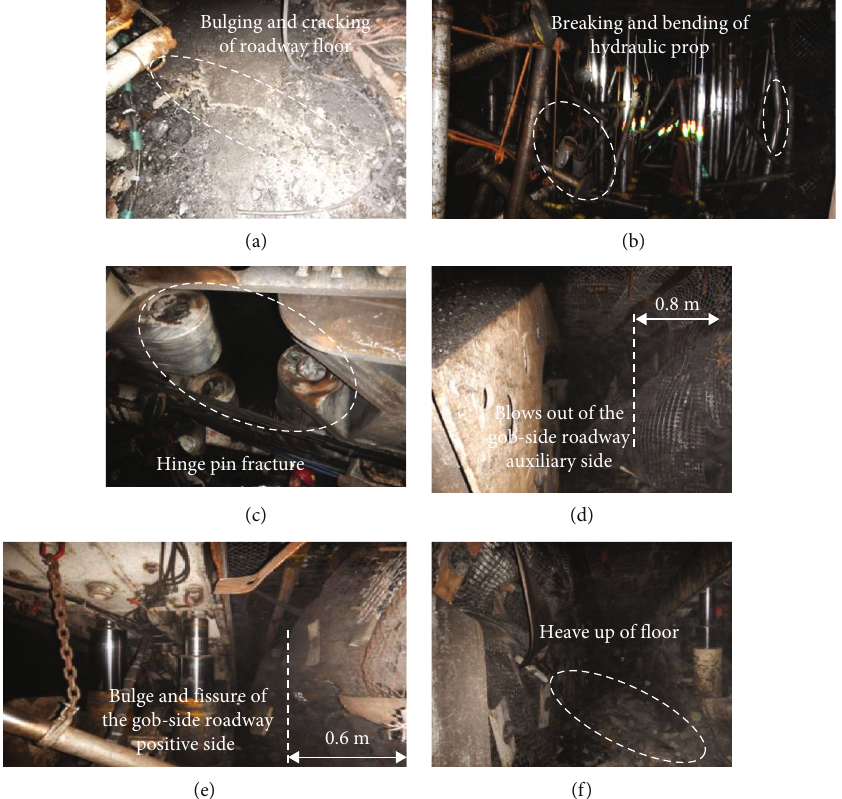
Figure 2: Strong ground pressure accident. (a) Bulge of working face 42105 roadway fl oor. (b) Breaking of hydraulic prop. (c) Fracture of hinge pin. (d) Bulge of gob-side roadway auxiliary side. (e) Bulge of gob-side roadway positive side. (f) Heave up of fl